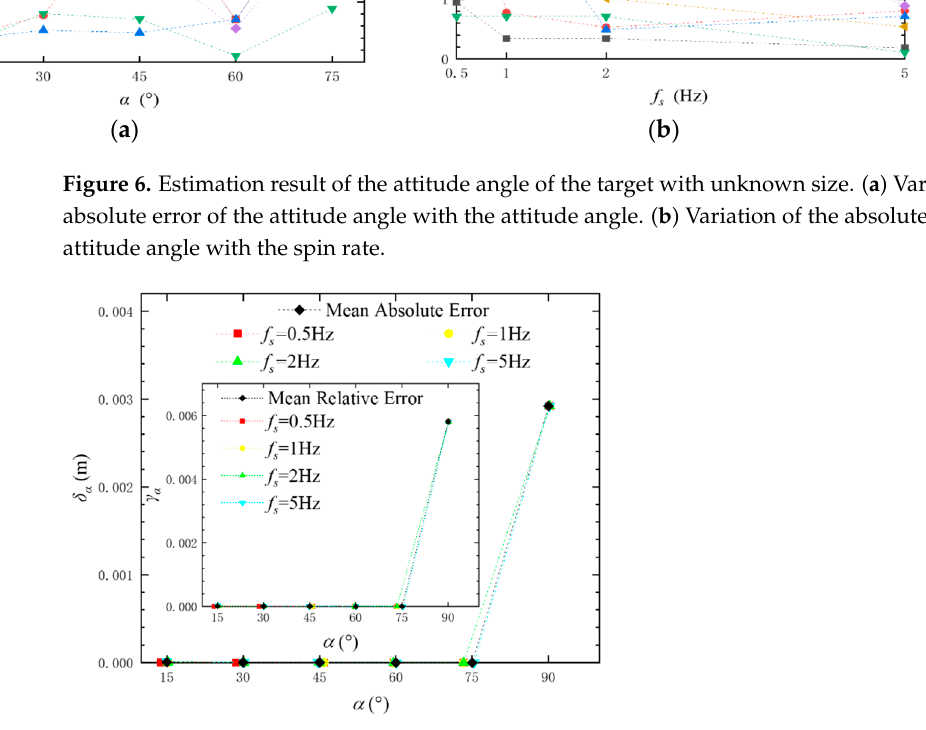
Figure 6. Estimation result of the attitude angle of the target with unknown size. ( a ) Variation of the absolute error of the attitude angle with the attitude angle. ( b ) Variation of the absolute error of the attitude angle with the spin rate.